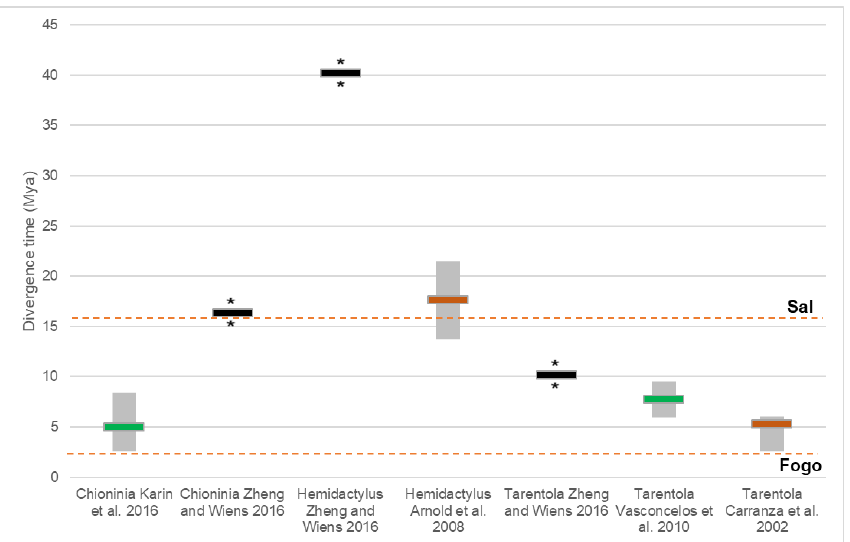
Figure 3. Calibration methods used with Macaronesian reptile lineages. Total number of calibration points (columns) and number of unresolved clades (red line). The average percentage of unresolved clades is shown within the columns as the number of unresolved clades / total number of clades.